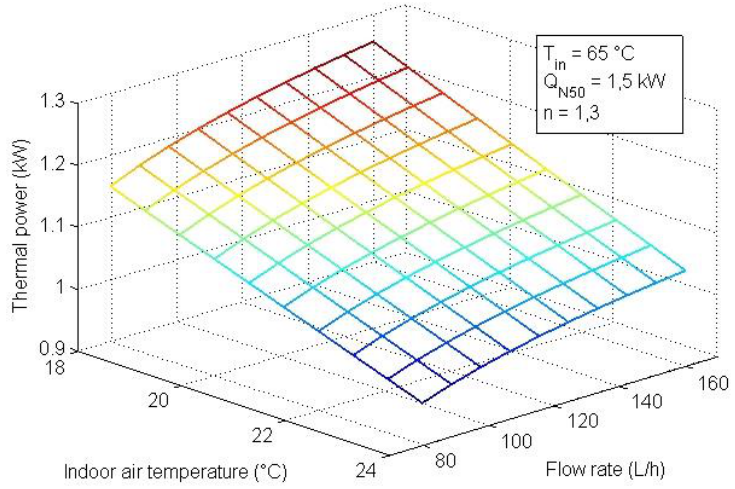
Figure 3. Dependence of radiator thermal power from indoor air temperature and water flow